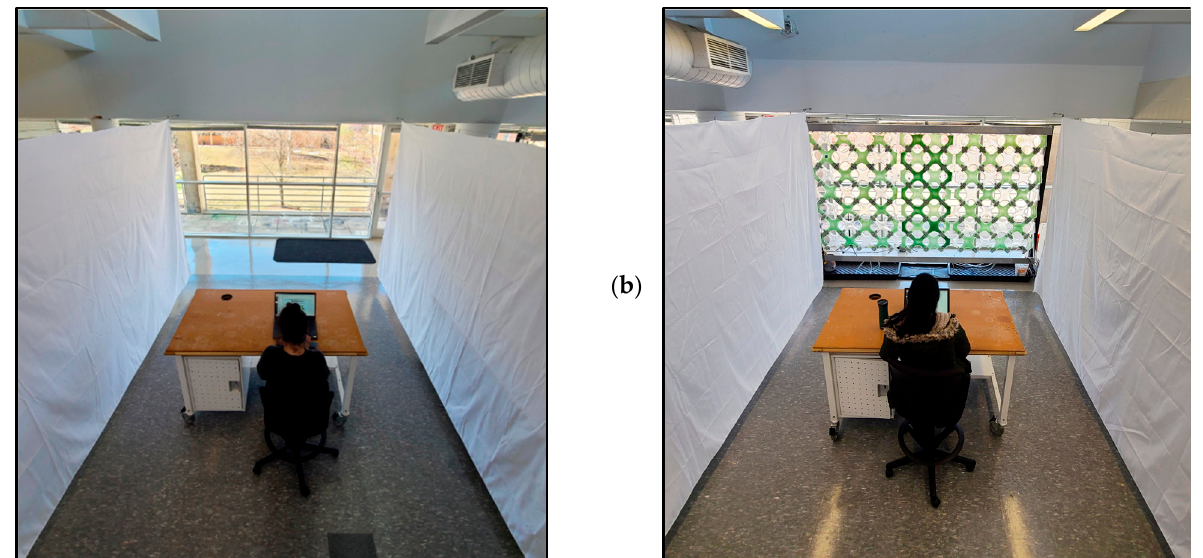
Figure 3. Picture of the experiment rooms with a participant: ( a ) without the microalgae façade and ( b ) with the microalgae façade.